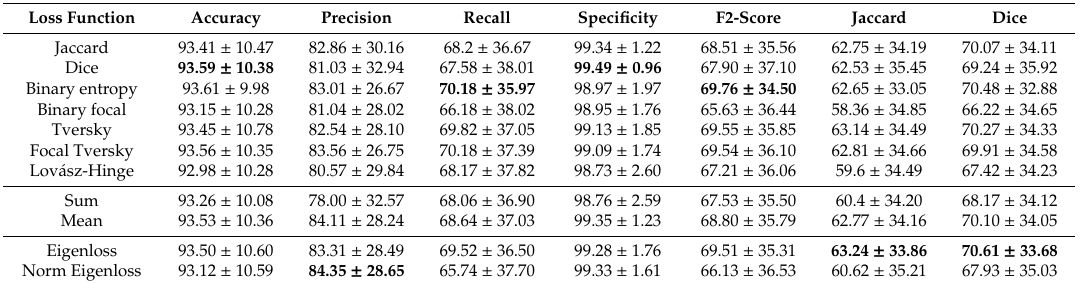
Table 3. LinkNet-VGG-16. Results of the model trained with the di ff erent loss functions, reported over the test set of CVC-EndoSceneStill. Best values are indicated in bold.